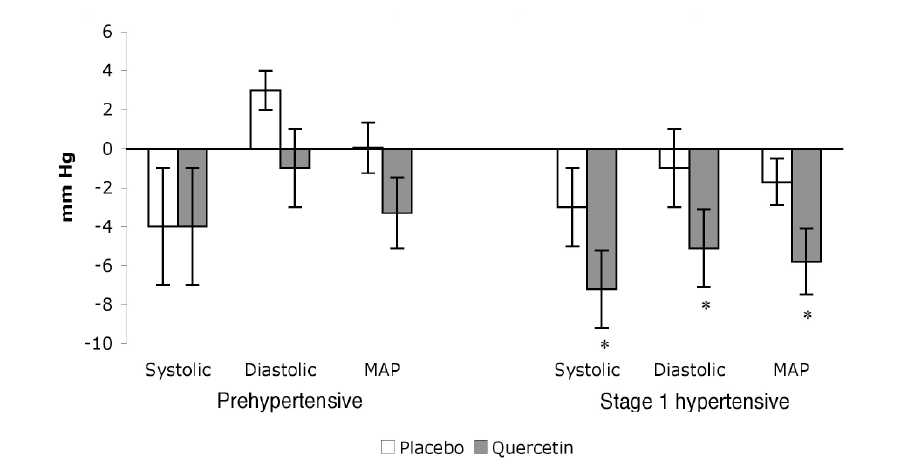
Figure 3. Reduction of BP from baseline in quercetin and placebo treated subjects. Data adapted from Edwards et al. [37]